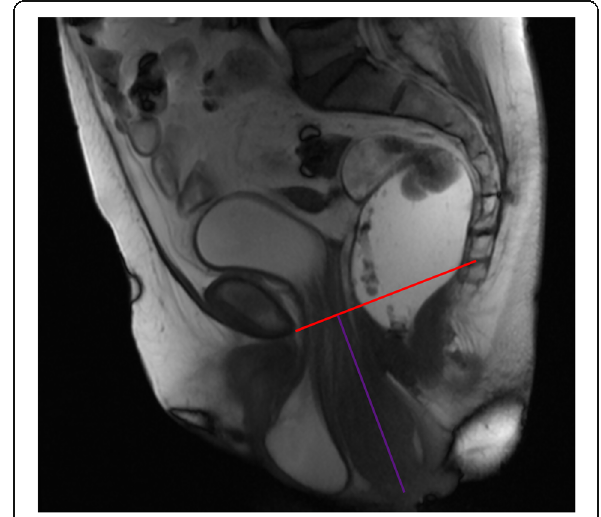
Fig. 11 Uterine prolapse. Sagittal midline TrueFISP image at rest revealing an everted uterus filling of the vaginal space, which extends below the distal third of the vagina. Red line : PCL; purple line : extent of the uterine prolapse